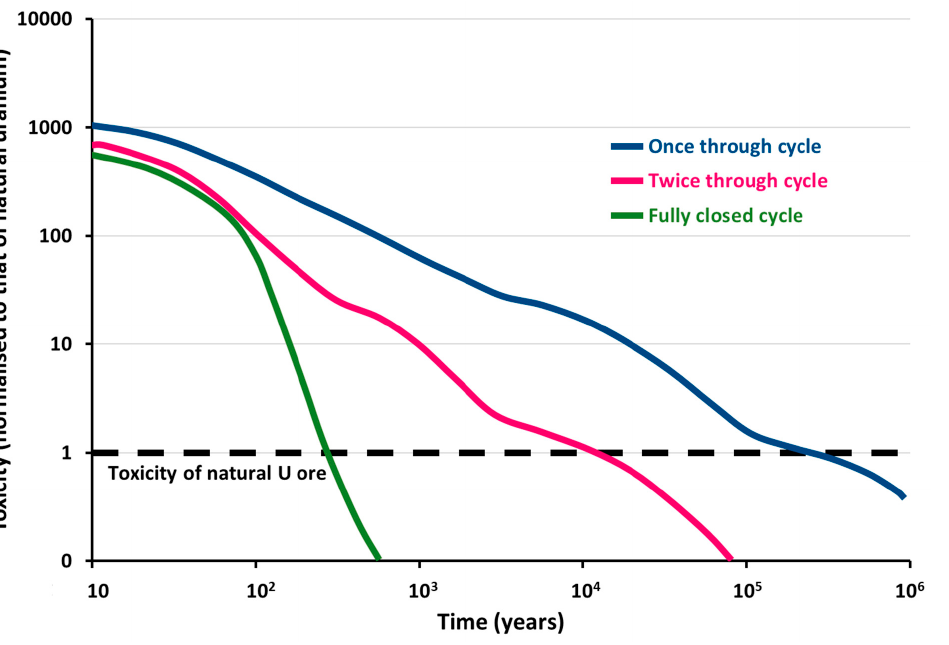
Figure 9. Evolution of the ultimate waste long ‐ term toxicity as a function of time for three different types of fuel cycles, normalised to that of the original uranium ore (redrawn from data in [22]). The reductions in heat generation and HLW volumes are illustrated quite clearly for three reference scenarios (the OTC, TTC and multi ‐ recycling) in Figure 10. The decay heat is shown for 50 and 200 years storage of HLW after reprocessing—the longer timeframe enabling the high ‐ heat ‐ generating fission products (caesium and strontium) to have decayed substantially. This reduction in heat generation enables waste canisters to be packed more densely and, hence, can lead to a reduction in the surface footprint and excavated volumes of a DGR.